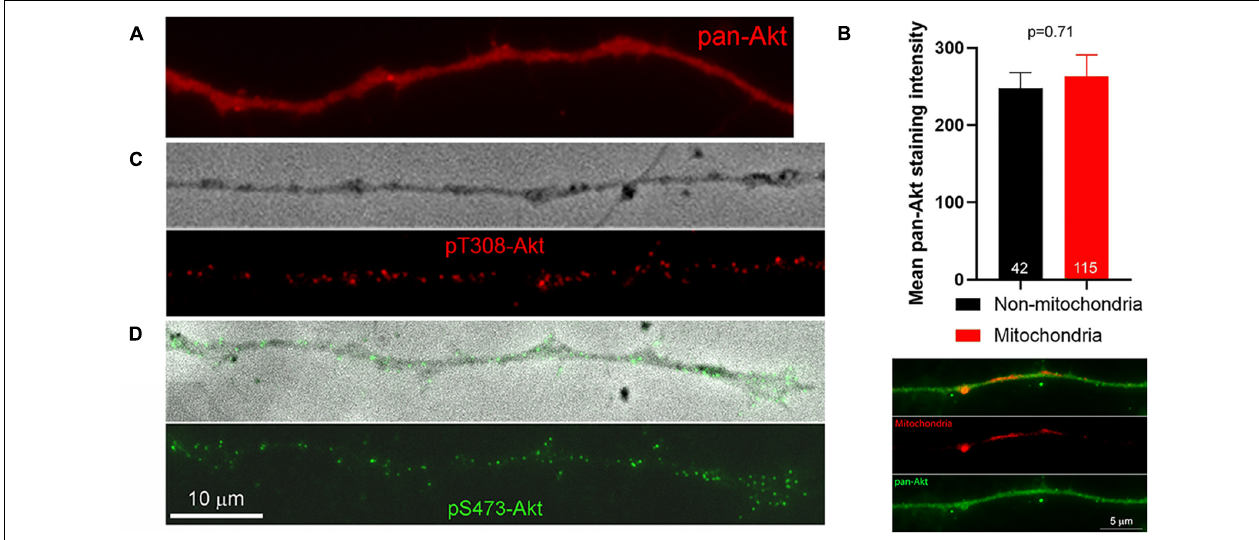
FIGURE 2 | Distribution of pan-Akt, pT308-Akt and pS473-Akt. (A) Top panel shows an example of an axon stained with a pan-Akt antibody. The distribution is uniform. (B) Graph showing the mean staining intensity of pan-Akt staining in axons ( n = 42) in segments devoid of mitochondria and those populated by mitochondria. An example of an axon stained with anti-pan-Akt and containing labeled mitochondria is shown below the graph. (C) Example of pT308-Akt staining along an axon treated with NGF for 10 min. The top panel shows a phase contrast image of the axon. (D) Example of pS473-Akt staining along an axon treated with NGF for 10 min. The top panel shows a phase contrast image of the axon with overlaid pS473-Akt. The scale bar in (D) also applies to (A,C) .